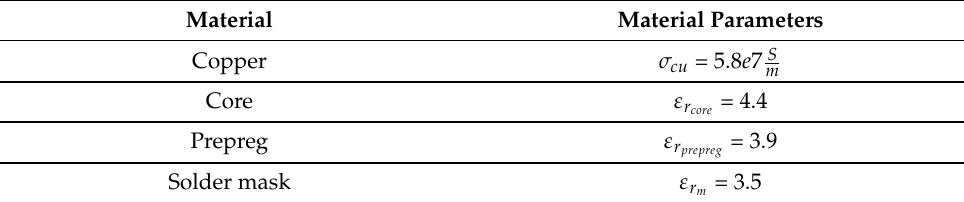
Figure 7. ( a , b ) are the top and bottom views of the 3D model of the test PCB. The 3D geometry of the PCB is imported from odb++ data files. ( c ) detailed stackup of the test PCB using 4 metal layers. Table 1. Material parameters used for the test